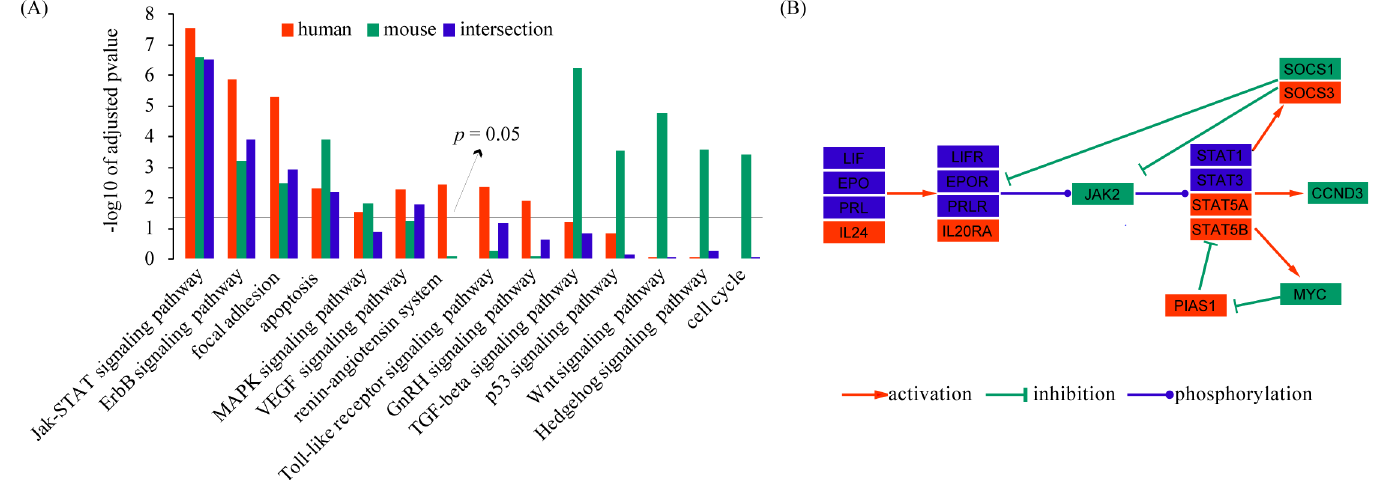
Fig 3. Pathway enrichment analysis of decidualization-related genes. (A) The figure shows the significantly enriched pathways identified by using DAVID online tools. The bars represent the enrichment p-value at logarithmic scale. (B) Visualization of the LIF-STAT signaling pathway. Nodes represent genes. The node color indicates the status of the gene as specific to human (red), specific to mouse (green), or shared by both (blue). Edges represent gene dependences derived from KEGG pathway database. Genes without a direct interaction with others are not included. This graph is generated using the Cytoscape software.